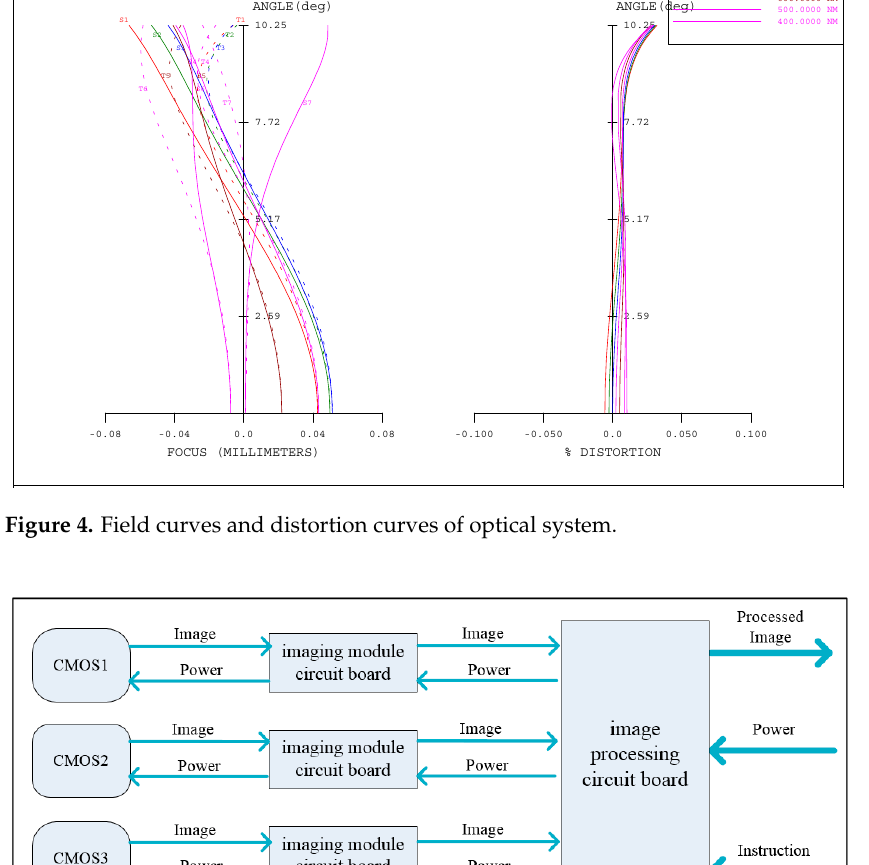
Figure 4. Field curves and distortion curves of optical system.